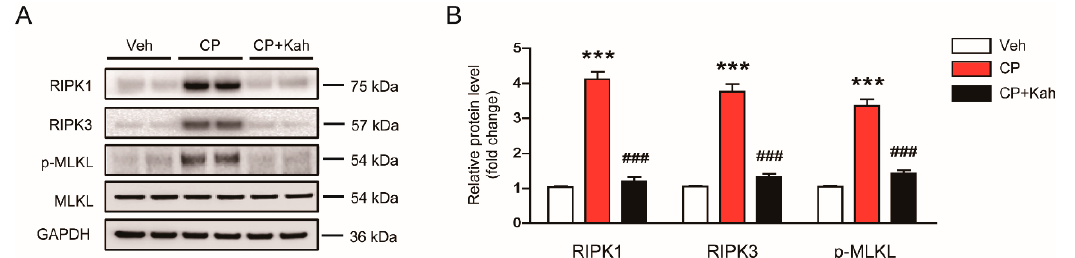
Figure 8. Effect of kahweol on tubular cell necroptosis in cisplatin-injected mice. ( A ) Western blotting of receptor-interacting serine/threonine protein kinase 1 (RIPK1), RIPK3, mixed-lineage kinase domain-like protein (MLKL), and p-MLKL. ( B ) Quantification of Western blots for RIPK1, RIPK3, and p-MLKL. GAPDH was used as an internal control. n = 8 per group. *** p < 0.001 vs. Veh. ### p < 0.001 vs. CP.